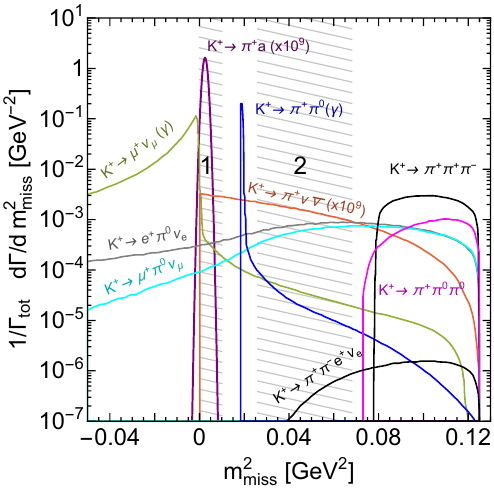
Figure 1 . Di(cid:11)erential distribution of m 2 for di(cid:11)erent K + decays taken from refs. [49, 75] and miss supplemented by the prediction for K + ! (cid:25) + a (purple) with C WW = (cid:3) = 5 (cid:1) 10 (cid:0) 4 TeV (cid:0) 1 and m a = 50 MeV, assuming a m 2 resolution of 0 : 001 GeV 2 . Here the regions labelled as \1" and \2" miss refer to the two signal regions of NA62, which are separated by the K + ! (cid:25) + (cid:25) 0